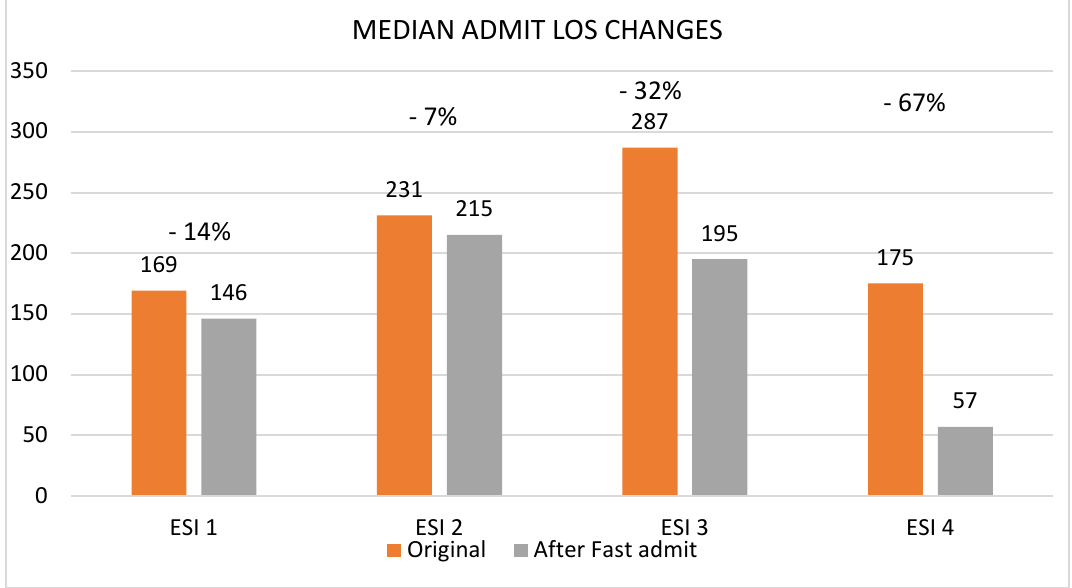
Figure 6 Median admit LOS comparison between the base model and after the Rapid-Admit modification (Image